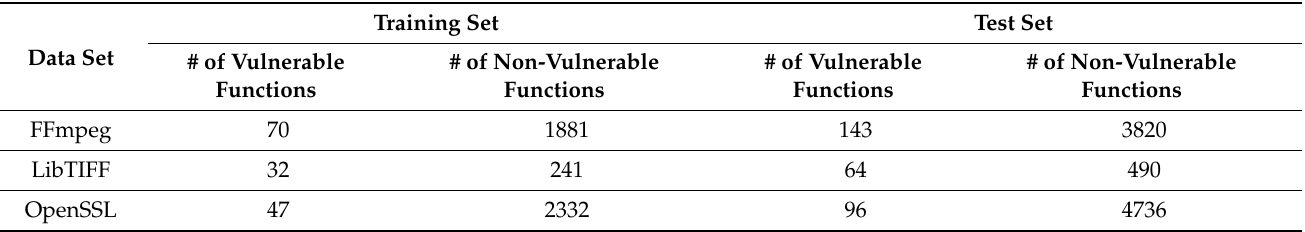
Table 2. The training/test partitions of the data sets. We set 33% of the training samples to simulate the case where there is a limited number of labeled vulnerability